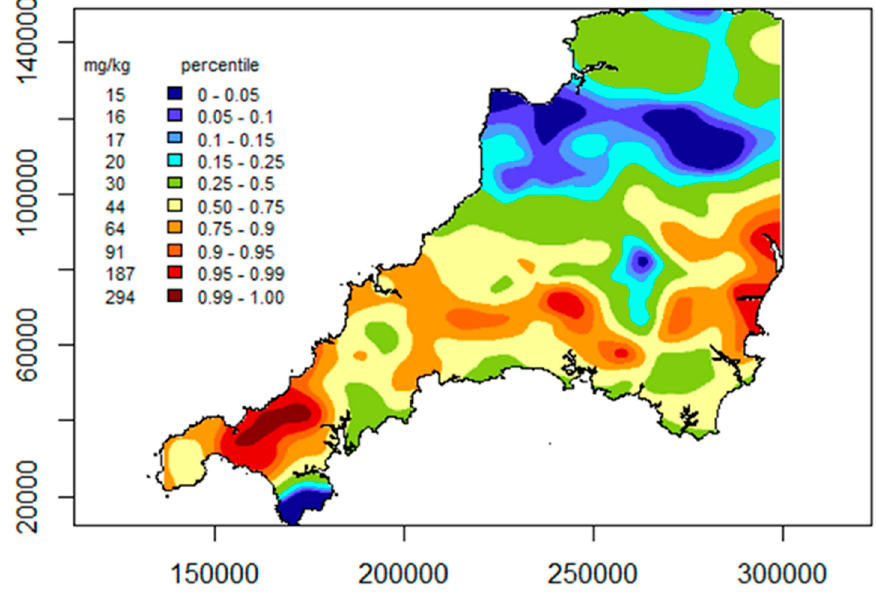
Figure 12. Interpolated map of predicted bioaccessible As in south- west England.